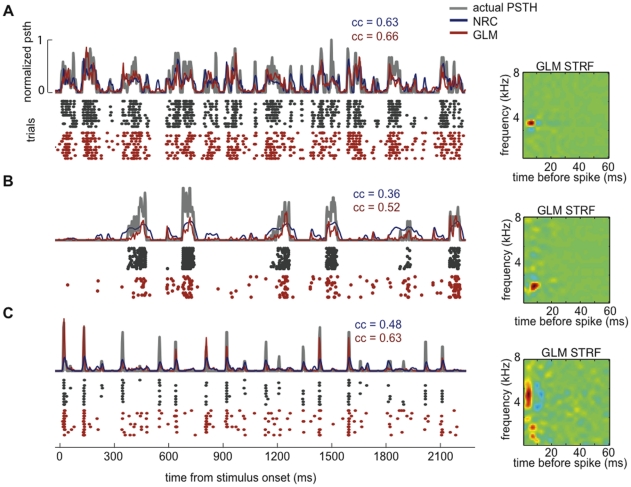
The GLM outperforms NRC when predicting responses to songs.(A)–(C) Examples of NRC and GLM response prediction (PSTHs and spike trains) and corresponding GLM STRFs for three auditory midbrain neurons. Recorded and predicted responses correspond to the song shown in Figure 2D. Spike trains and PSTHs were computed with a 3 ms time bin and PSTHs were smoothed with a 5 ms Hanning window prior to computing correlation coefficients. (STRFs have been up sampled by a factor of 3 for visualization). The GL model performs consistently better than NRC when used to predict average responses to a validation stimulus. In addition, the GLM spike-train predictions capture the overall structure of the actual spike trains.